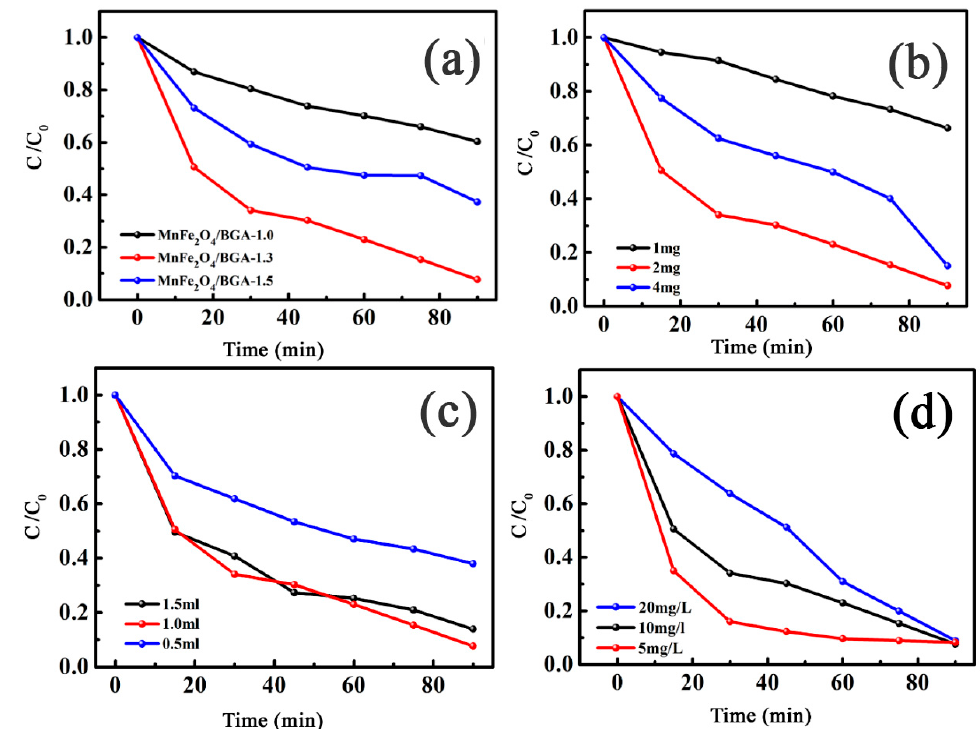
Figure 7. Effects of experimental parameters on degradation of RhB: ( a ) composition of MnFe 2 O 4 /BGA (dose of catalyst: 2 mg, volume of 30% H 2 O 2 : 1.0 mL, [RhB]: 10 mg/L, volume of RhB solution: 50 mL), ( b ) catalyst dosage (MnFe 2 O 4 /BGA − 1.3, volume of 30% H 2 O 2 : 1.0 mL, [RhB]: 10 mg/L, volume of RhB solution: 50 mL), ( c ) volume of 30% H 2 O 2 (MnFe 2 O 4 /BGA − 1.3, catalyst dose: 2 mg, [RhB]: 10 mg/L, volume of RhB solution: 50 mL), and ( d ) initial RhB concentration (MnFe 2 O 4 /BGA − 1.3, catalyst dose: 2 mg, volume of 30% H 2 O 2 : 1.0 mL, volume of RhB solution: 50 mL).